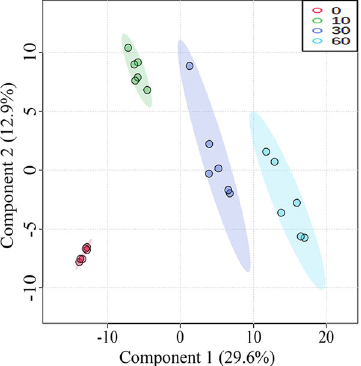
Fig. 6 The steaming times for the four groups in different colors are 0, 10, 30, and 60 min. PLS-DA score of the sum individual lipids in tilapia muscle and juice at different steaming times by Metaboanalyst 5.0 software according to the normalized MS